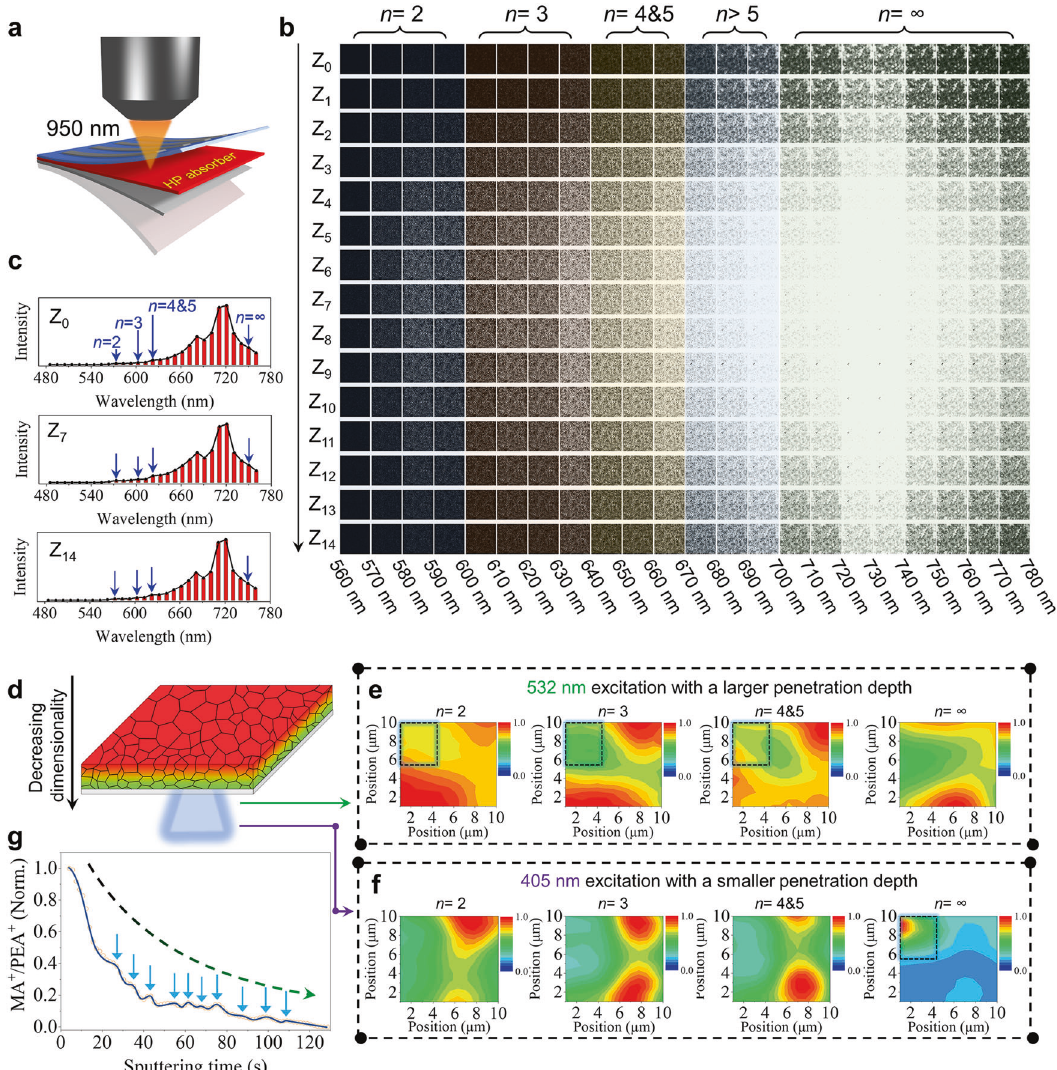
Fig. 4 | Depth-pro fi le phase arrangement in the mixed-dimensional 2D/3D HP fi lm.a Schematicdiagramofthetwo-photonPLmapping. b Thedepth-pro fi letwo- photonPLmappingresult.Z 0 andZ 14 representthetopandthebottomofthe fi lm, respectively. The other cross-sections are evenly spaced between Z 0 and Z 14 (denoted as Z 1 , Z 2 , Z 3 , etc.). The PL mapping was conducted for each 10nm band, and the relative brightness of the picture re fl ects the PL intensity. The monitoring area is 58.7 μ m×58.7 μ m. The pumping wavelength is 950nm. c Reorganized PL spectra of the Z 0 , Z 7 , and Z 14 sections. d Schematic diagram of the one-photon PL mapping probing at the bottom surface of the fi lm. e One-photon PL mapping